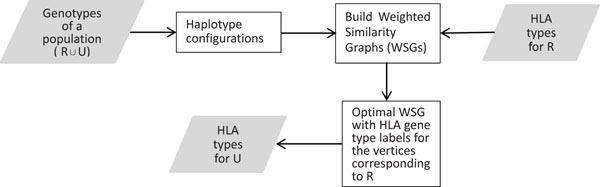
A sketch of WSG-HI